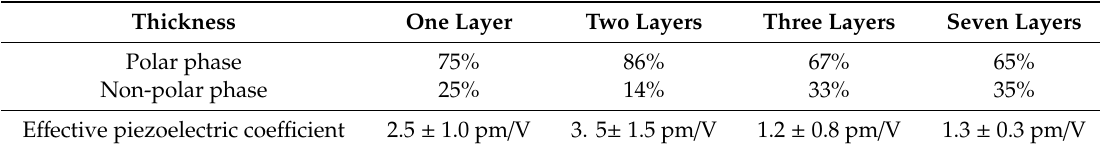
Figure 3. PFM images and phase distribution images in: ( a , e , i ) one-layer; ( b , f , j ) two-layer; ( c , g , k ) three-layer; ( d , h , l ) seven-layer HTD BFO films. ( a – d ) Topography; ( e – h ) vertical PFM images; ( i – l ) distribution of the piezoelectrically-active (red) and non-active (blue) phases. Table 1. Phase distribution and piezoelectric coe ffi cient for the HTD BFO thin films as a function of